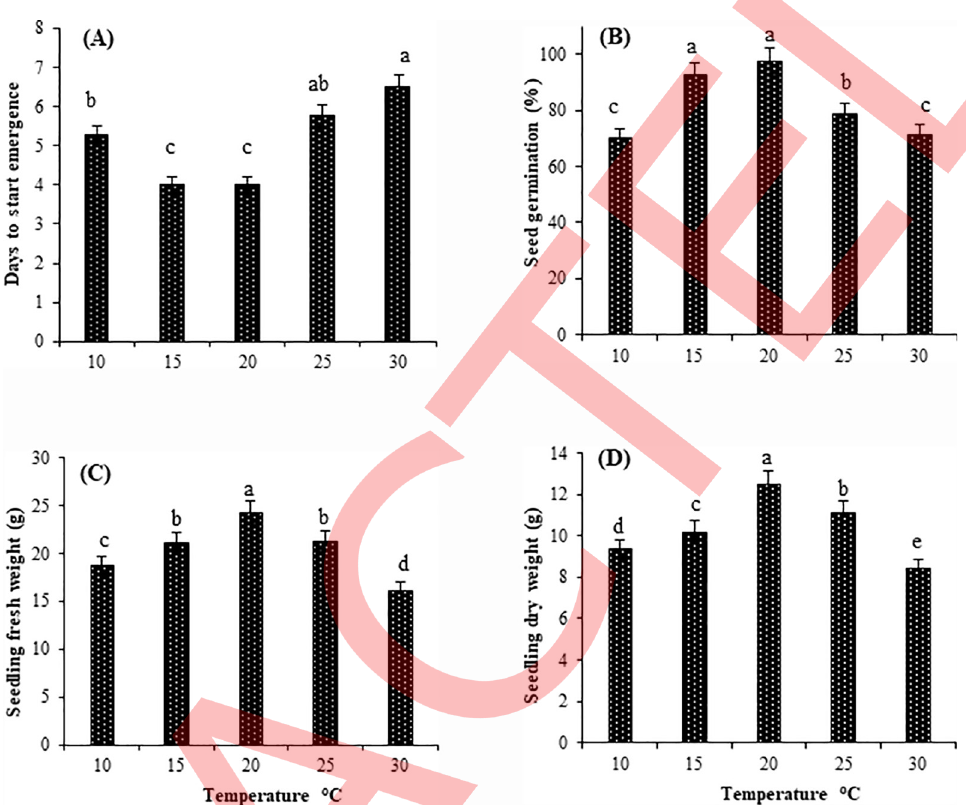
Experiment 3: Effect of different wild oat-wheat densities on the growth of each other Different wild oat-wheat density (WWD) combinations significantly altered seed germination and biomass production of both species and number of tillers per plant of wheat (Table 3). Seed germination of wheat remained same under all WWD combinations except 8:0 (Fig 3A). Fresh and dry biomass production of wheat decreased with increasing wild oat density and decreasing wheat density. The highest fresh and dry biomass production of wheat were recorded under 0:8 (0 wild oat seeds and 8 wheat seeds), whereas the lowest fresh and dry bio- mass production were recorded for 8:0 (Fig 3C and 3D). Number of tillers per plant decreased with increasing wild oat density and decreasing wheat density. The highest number of tillers per plant was recorded under 0:8, whereas the lowest was recorded for 8:0 (Fig 3B). Seed germination of wild oat remained same under all density combinations except 0:8 (0 seeds per pot of wild oat and 8 seeds of wheat). These results indicated that different WWD combinations did not affect the seed germination of wild oat (Fig 4A). Fresh biomass of wild oat decreased with increasing wheat density and decreasing wild oat density. The highest fresh biomass was recorded under 8:0 (8 wild oat seeds and 0 wheat seeds), whereas the lowest was noted for 0:8 (Fig 4B). Dry biomass decreased with increasing wheat density and decreasing wild oat density. The highest dry biomass production was recorded under 8:0 (Fig 4C).